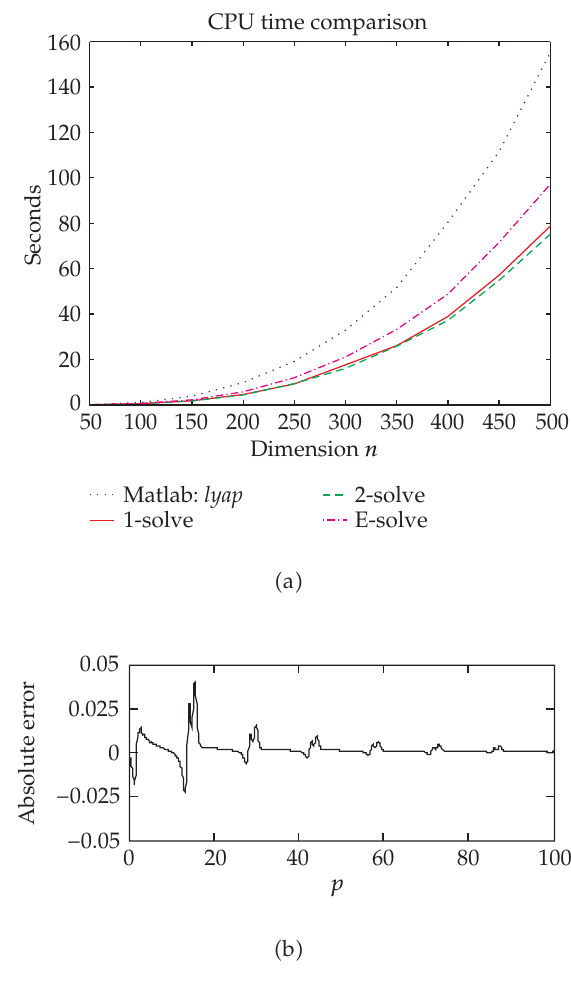
Figure 2 . Transform’s